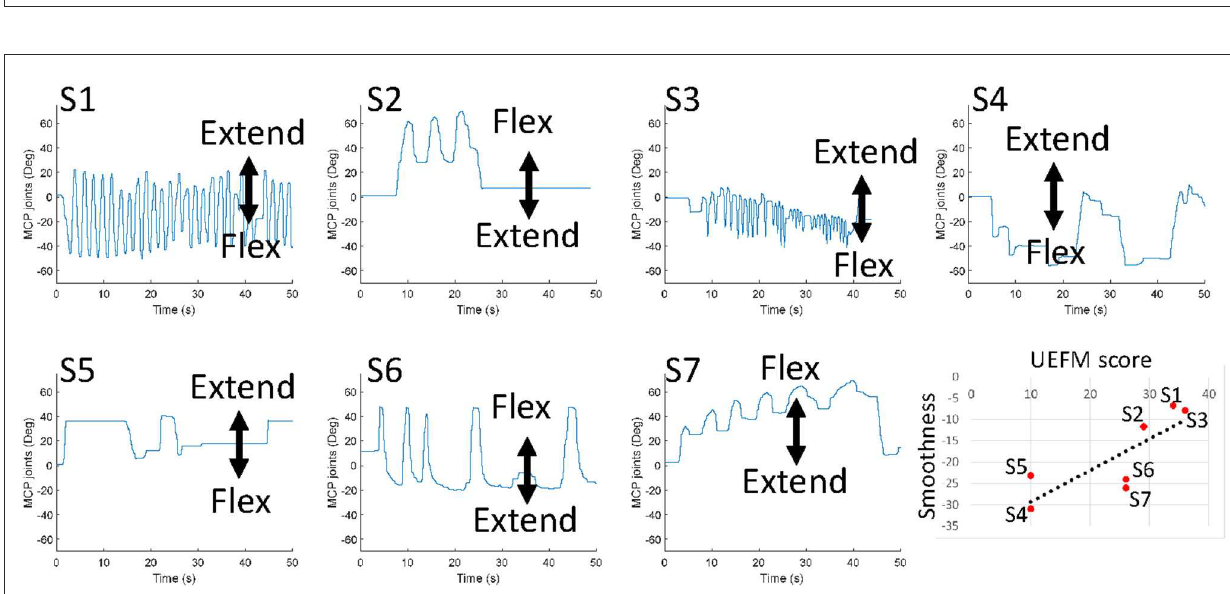
FIGURE4 Free movements of the MCP joints of individual participants. The last plot presents the trend of movement smoothness versus the total UEFM